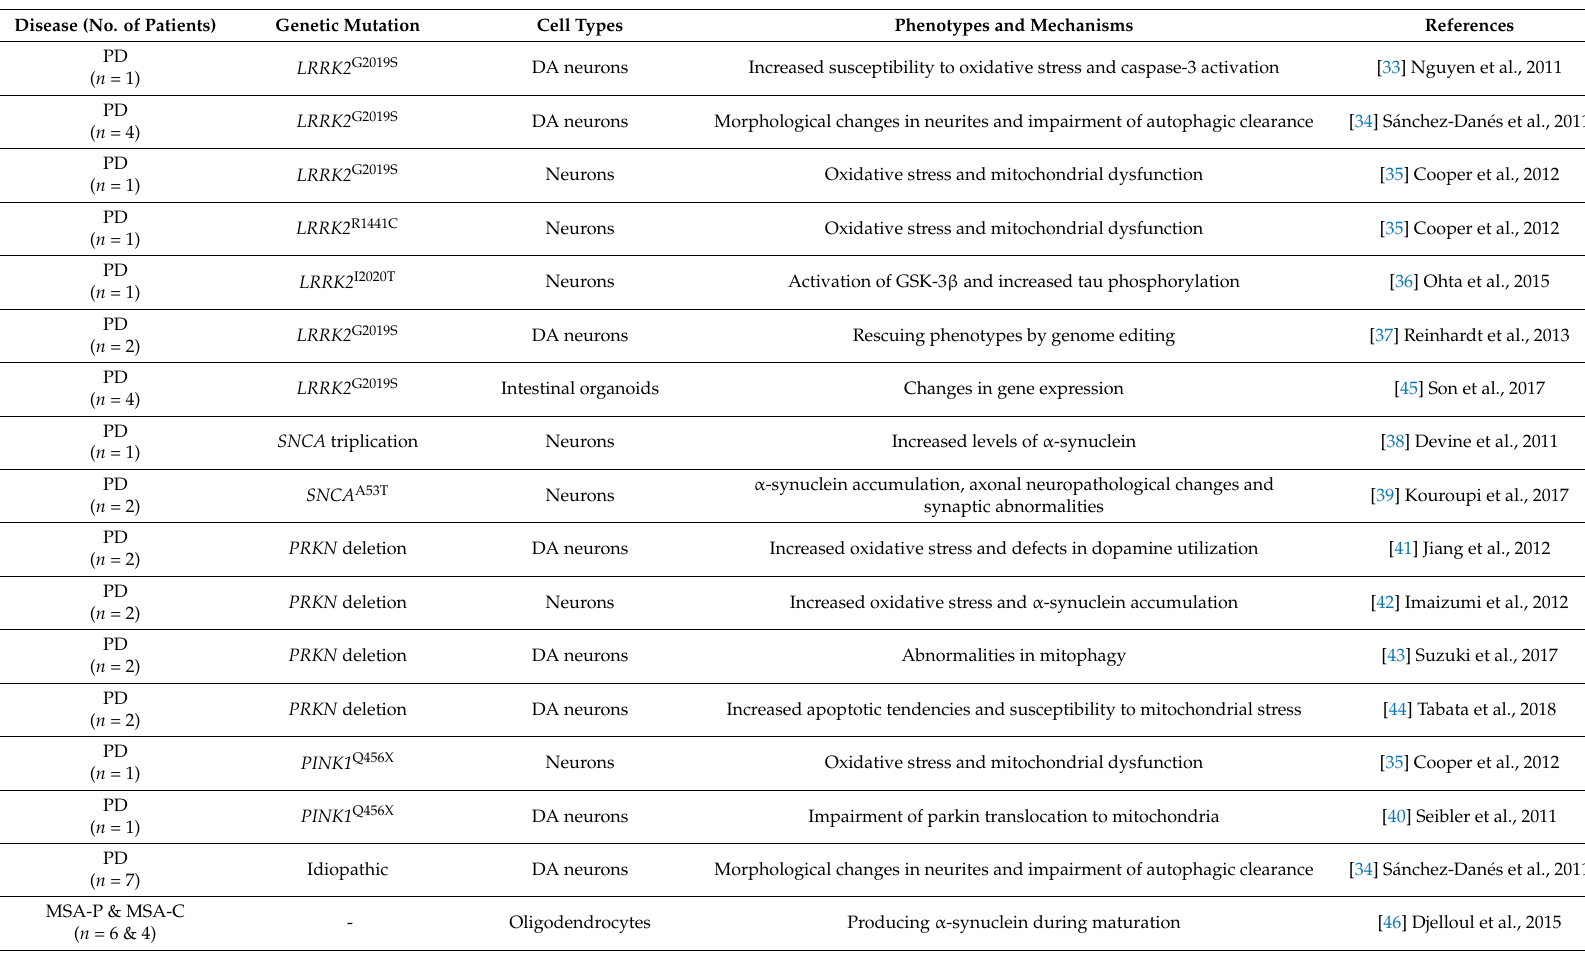
Table 1. Summary of modeling of Parkinson’s disease and atypical parkinsonian syndromes using induced pluripotent stem cells (iPSCs). PD, Parkinson’s disease; MSA, Multiple system atrophy; FTDP-17, frontotemporal dementia and parkinsonism linked to chromosome 17; LRRK2 , Leucine-Rich Repeat Kinase 2 ; PINK1 , PTEN-induced putative kinase 1 ; MAPT , microtubule-associated protein tau ; TH, tyrosine hydroxylase. Disease (No. of